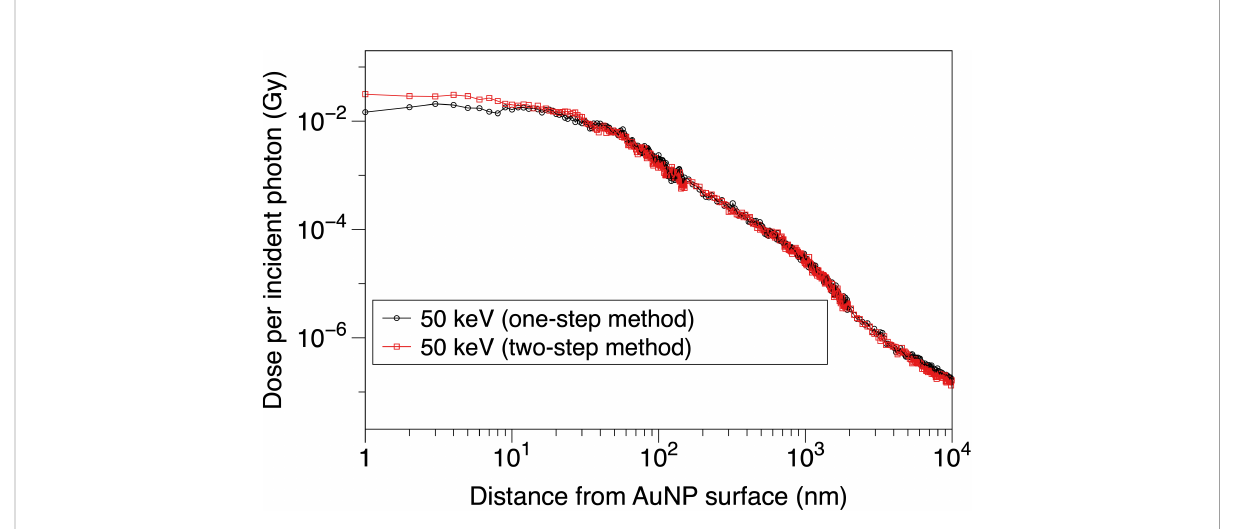
FIGURE 4 Dose distribution per incident photon vs. distance from AuNP surface.